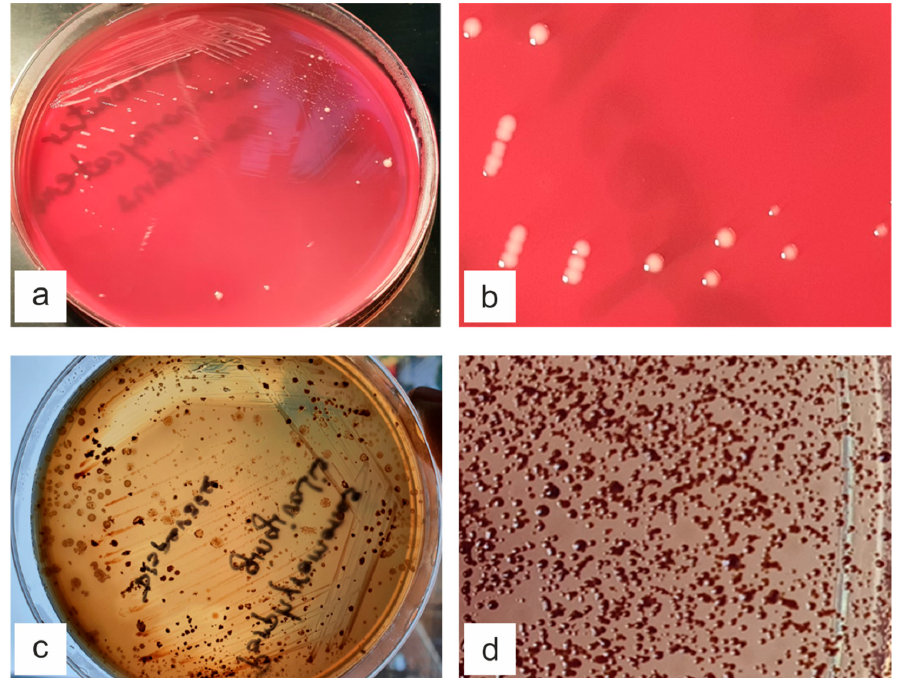
Figure 2. The colonies of strains A. actinomycetemcomitans (ATCC 29522) and P. gingivalis (ATCC 33277) after seven days of incubation at controlled temperature of 37 ± 0.1 °C in anaerobiosis, in 5% sheep blood agar medium: ( a ) A. actinomycetemcomitans culture on blood agar medium: Petri dish overview; ( b ) A. actinomycetemcomitans colonies on blood agar medium: detailed image of the colo- nies; ( c ) P. gingivalis culture on blood agar medium: Petri dish overview; ( d ) P. gingivalis colonies on